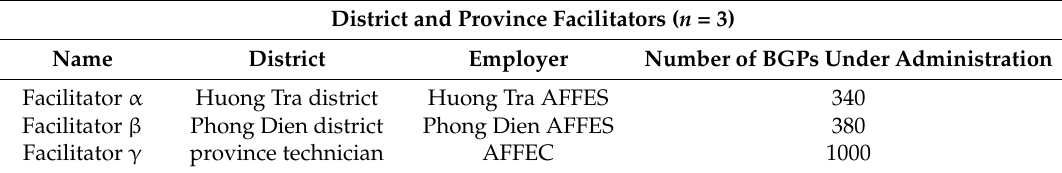
Table 2. Data of biogas plants (BGPs) under the administration of district and province